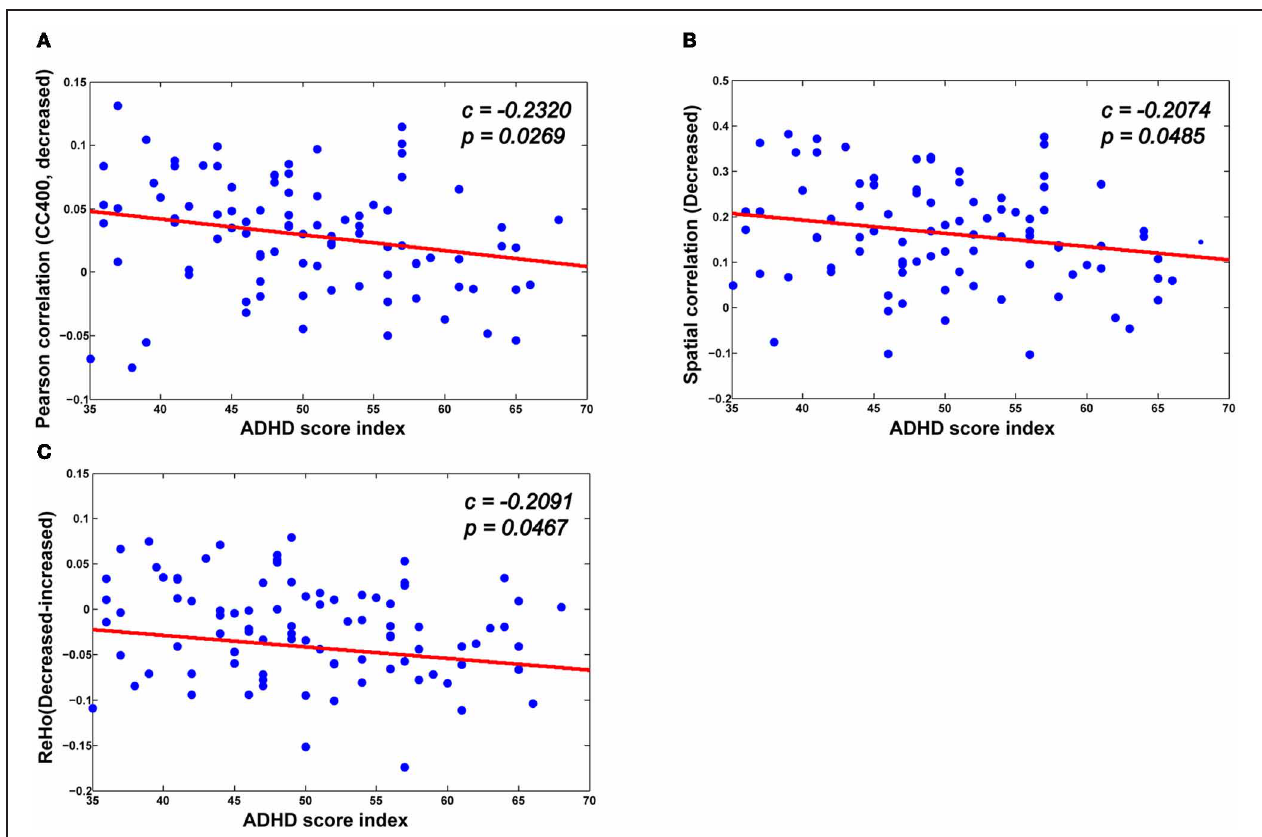
FIGURE 7 | The correlation between various biomarkers and ADHD indices. (A,B) The mean decreased Pearson correlation and spatial correlation show negative correlation with the ADHD index. (C) There